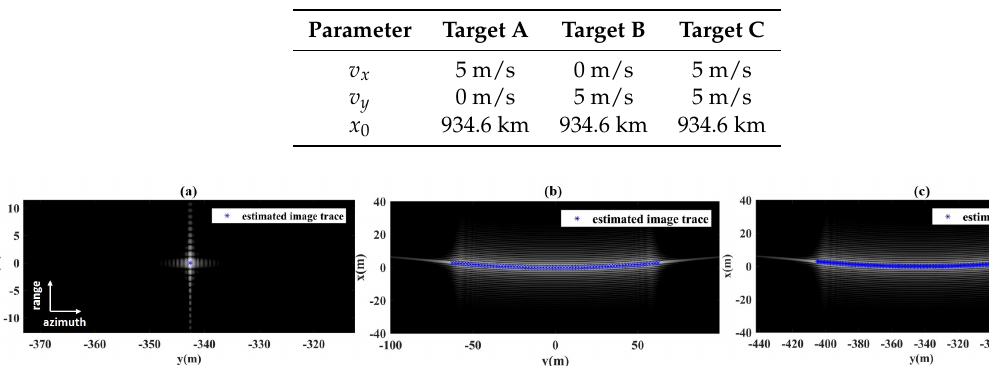
Table 3. Target motion parameters.